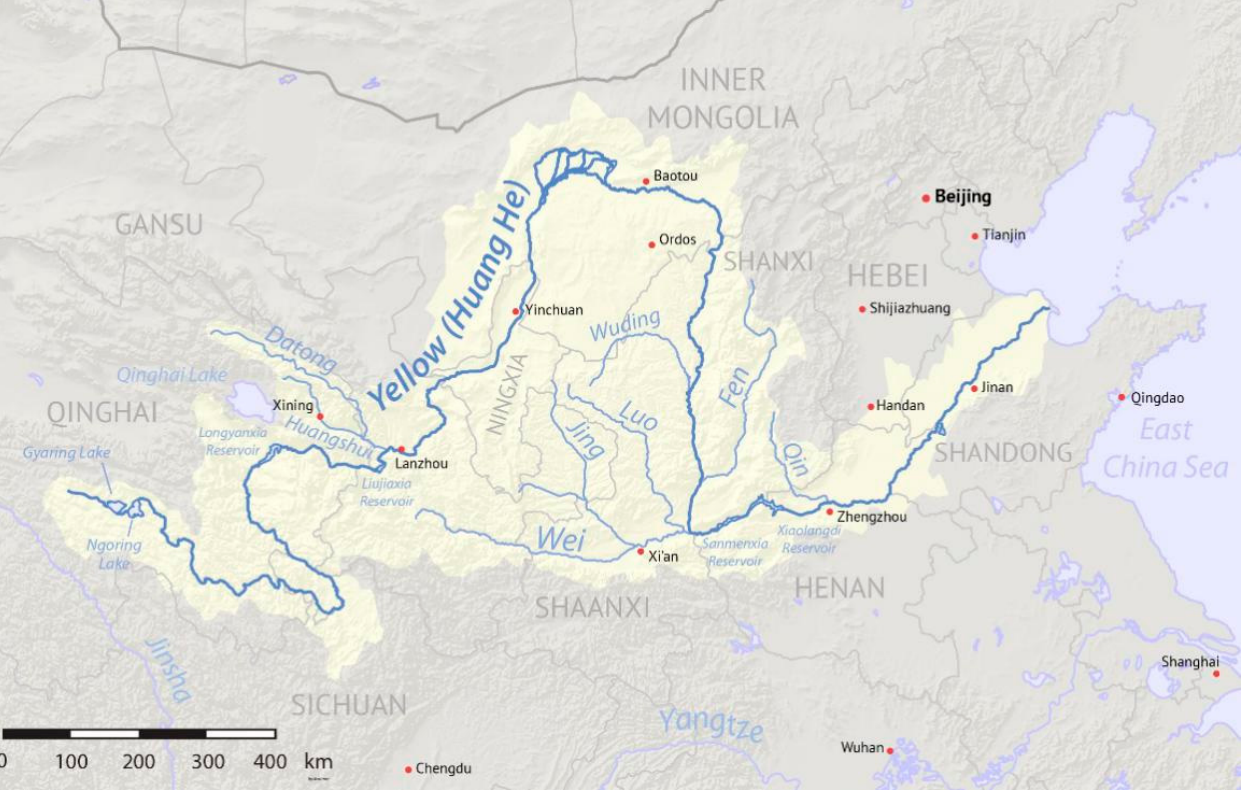
Figure 1. The upper and middle Yellow River drainage system diagram. Source: China Water Resources Yearbook, 2018.